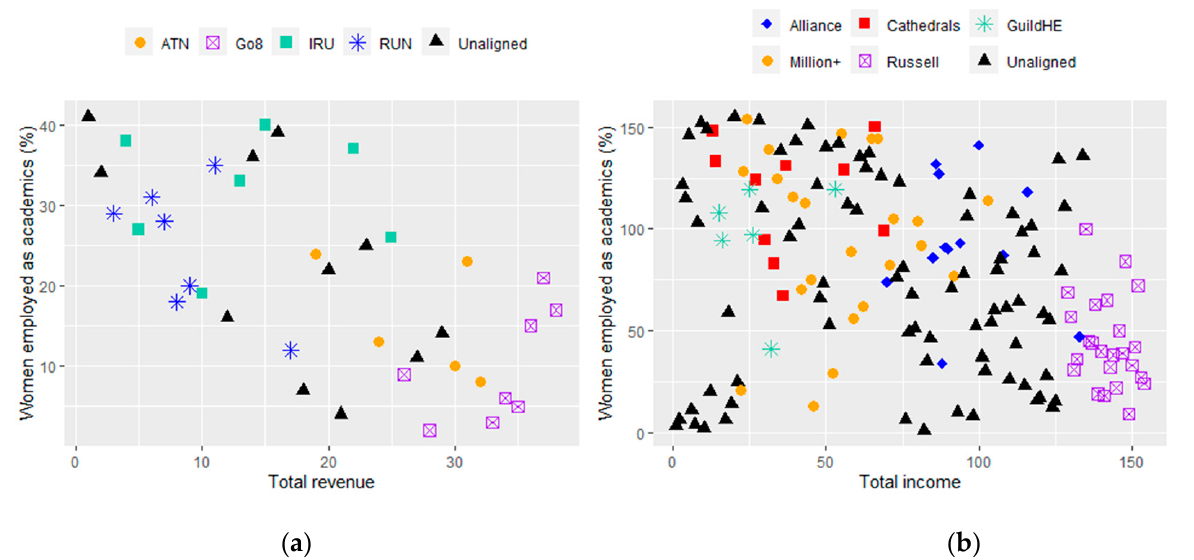
Figure 4. Scatterplot between ranks in percentages of women in academic roles and ( a ) total revenue in AU$ across Australian universities and ( b ) income in GBP across UK universities by university groupings, 2020. The data are presented in terms of ranks. Data sources: Department of Education, Skills and Employment, Higher Education Statistics Agency; Microsoft Academic, Unpaywall, Crossref. Image: Curtin Open Knowledge Initiative.